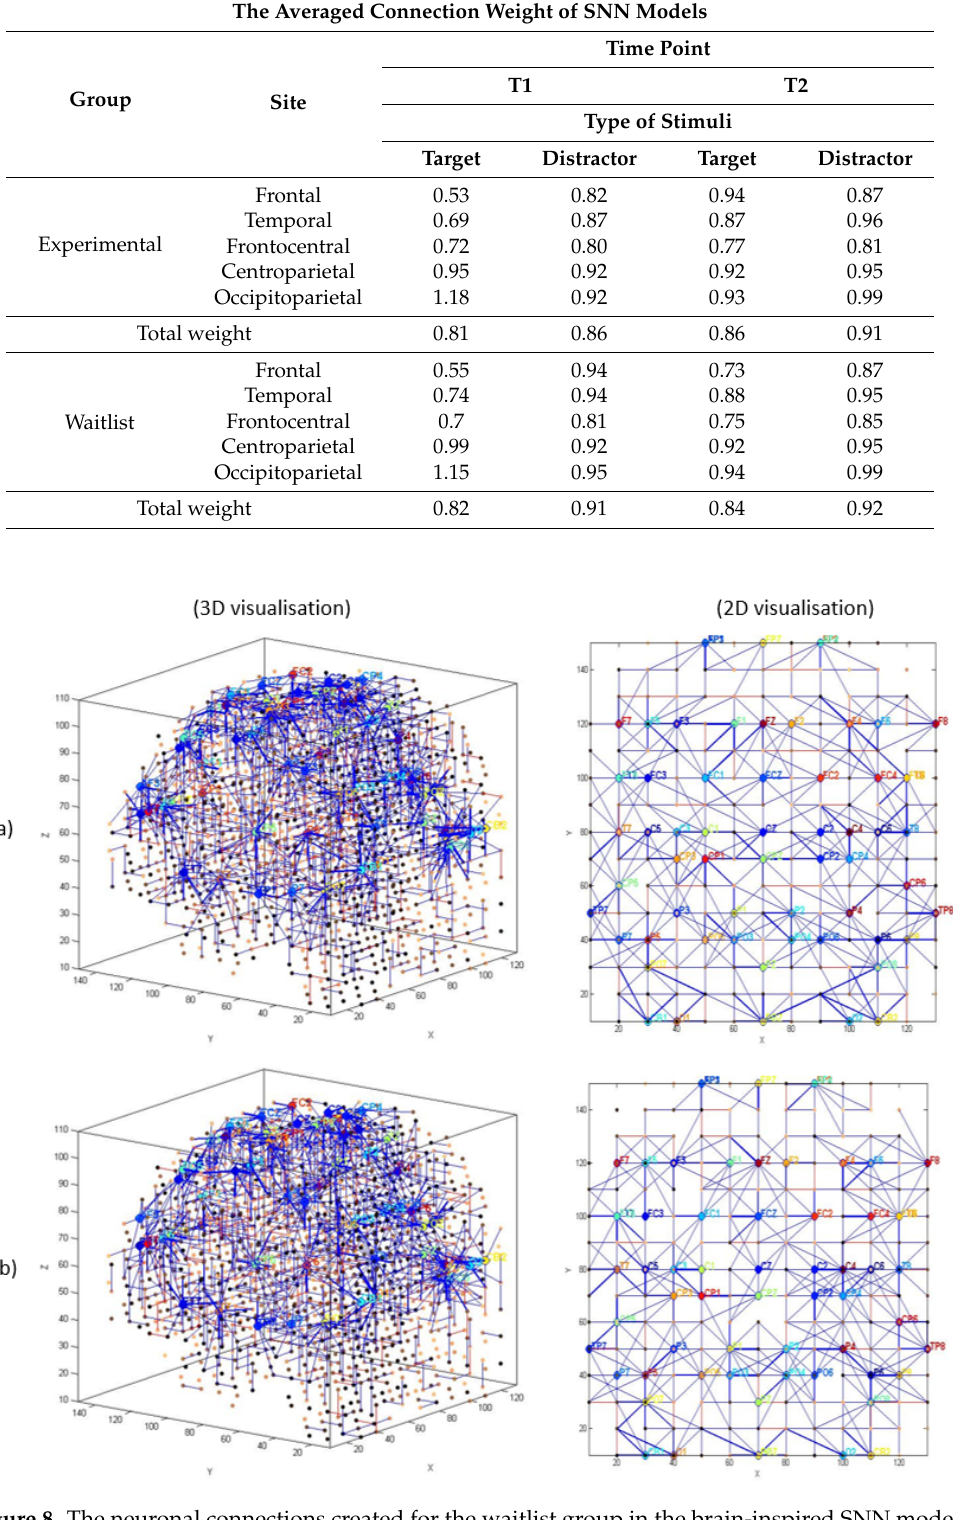
Figure 8. The neuronal connections created for the waitlist group in the brain-inspired SNN models reflect the functional connectivity in response to target stimuli ( a ) before (T1) and ( b ) after the mindfulness training (T2).